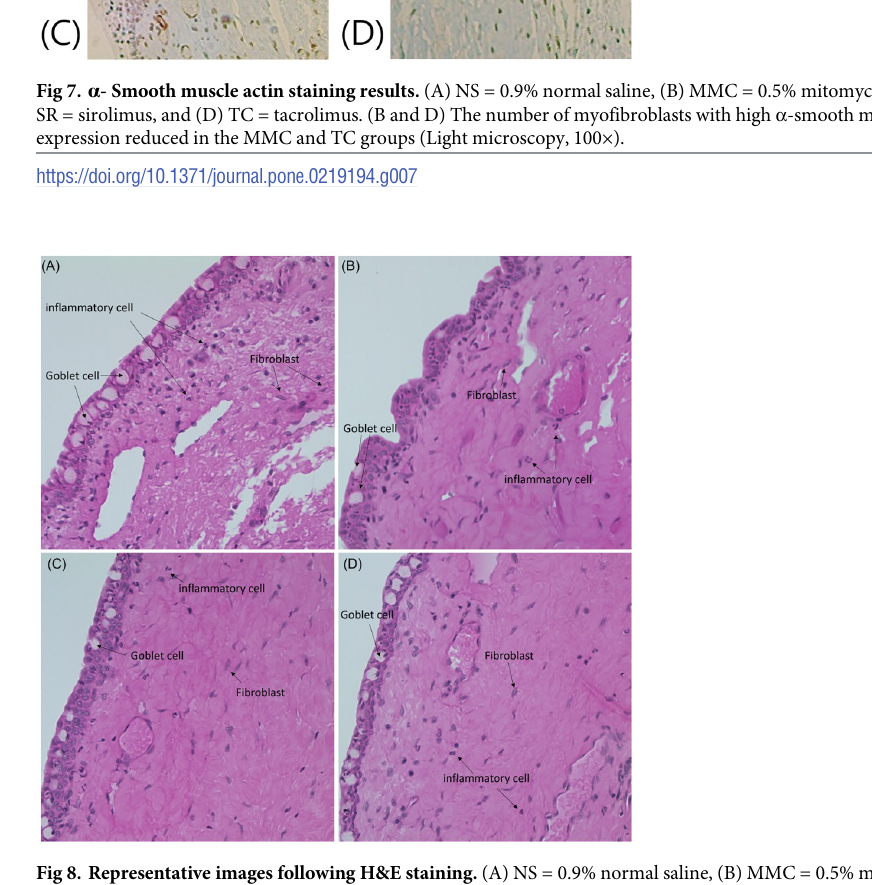
PLOS ONE | https://doi.org/10.1371/journal.pone.0219194 July 5,